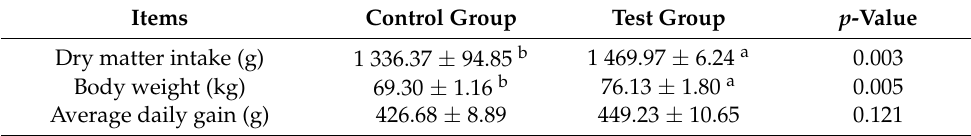
Table 3. Effect of concentrate supplementation on growth performance of yak